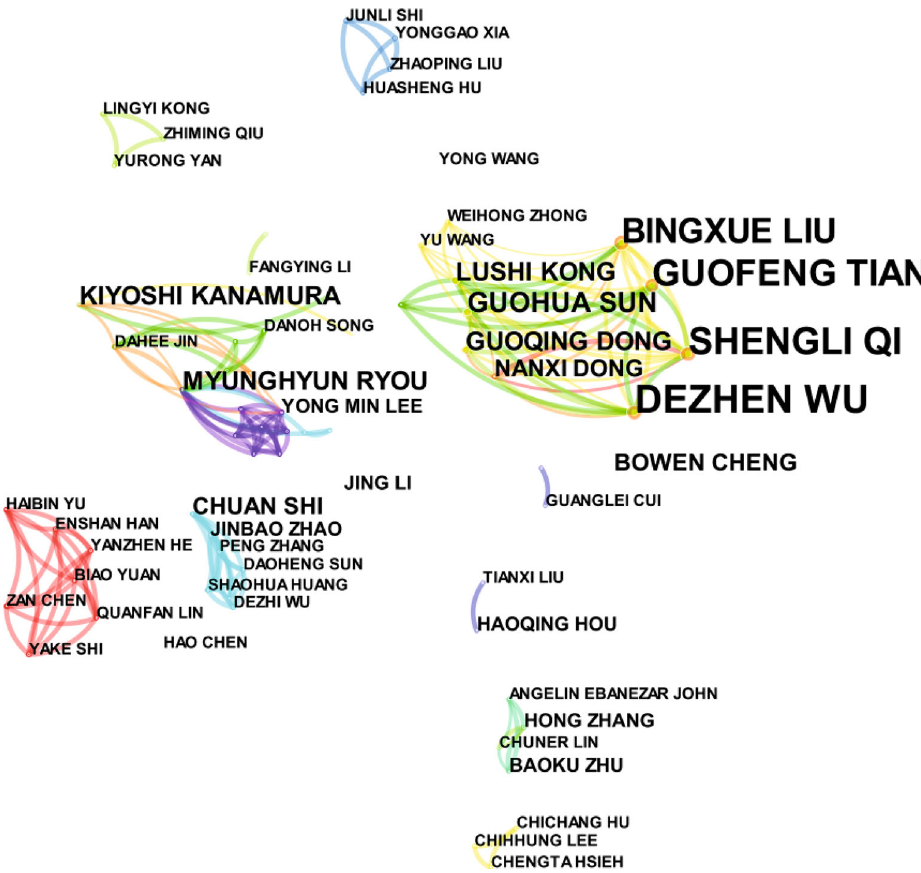
Figure 5: Author collaboration network